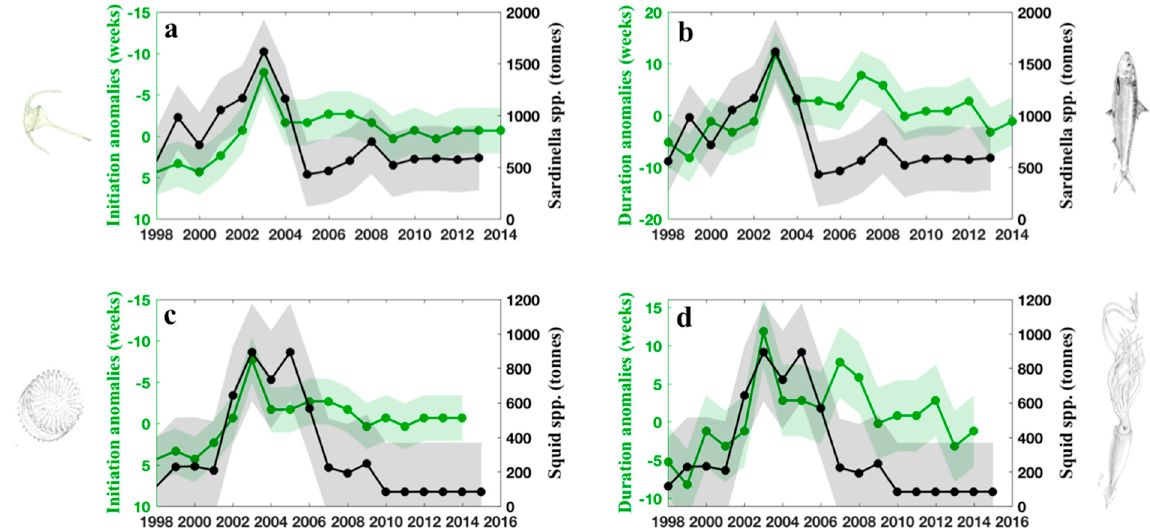
Figure 7. ( a ) Interannual variability in the landings of Sardinella spp. (tonnes) and the anomalies of bloom initiation (weeks) during the period 1998 to 2014. We note that one year was subtracted from the time series of Sardinella landings, and the plotted time series corresponds to one year after the phytoplankton bloom ( year t + 1 ). (i.e., the interannual variability in the timing of food availability is evident in the catch of the following year). ( b ) Interannual variability in the landings of Sardinella spp. (tonnes) and the anomalies of bloom duration (weeks), during the period 1998 to 2014. As in ( a ), one year subtracted was subtracted from the landings data to account for the 1-year lag between the phenology metrics and Sardinella landings. The light green and grey lines represent phytoplankton and fisheries datasets (respectively) and the shadings represent ± 1 standard deviation for both variables. ( c,d ) as seen in ( a,b ), but for landings of Squid spp. between 1998 and 2016. Please note the reversed y-axes in Figure 7a,c, where negative anomalies (upper values on the y-axes) are indicative of an earlier bloom initiation (weeks). All data were averaged over the northern and central Red Sea ecoregion (as described in Section 2.1).